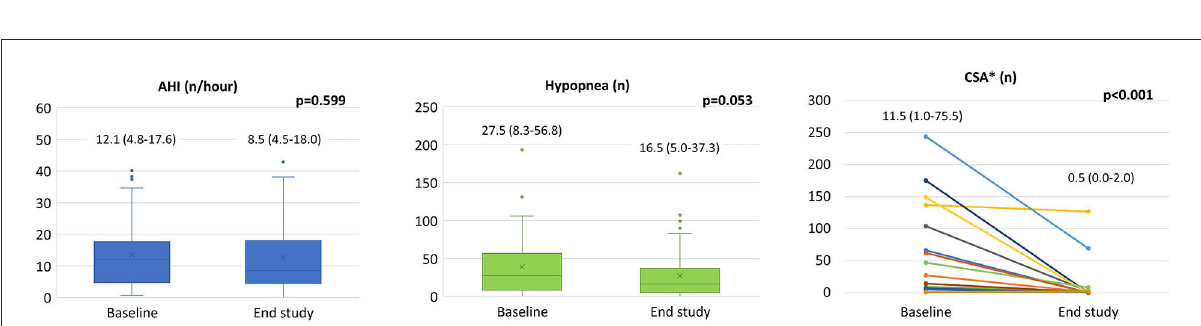
FIGURE2 Sacubitril/Valsartan effects on sleep apneas. In the whole population we observed a significant reduction in CSA (see text) with no differences in AHI from baseline to the end of follow-up (left panel). In patients with CSA at baseline ( n = 22) a significant reduction of CSA was obtained after Sacubitril/Valsartan therapy (right panel). Data presented as medians and interquartile ranges. AHI: apnea hypopnea index; CSA: central sleep apneas. *Analysis conducted only on patients with CSA > 0 at baseline ( n =